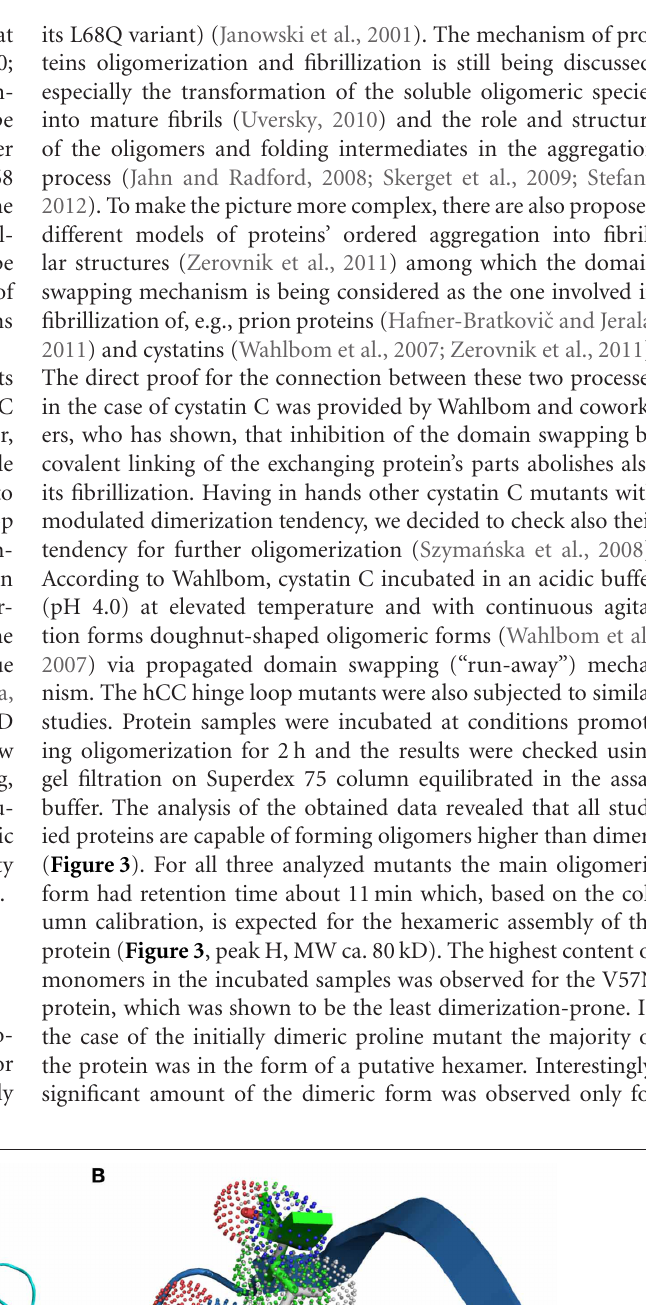
3S67); (B) molecular contacts of Val68 (van der Waals radius as green dots) and Leu68 (gray dots) residues. Figure prepared using PyMol